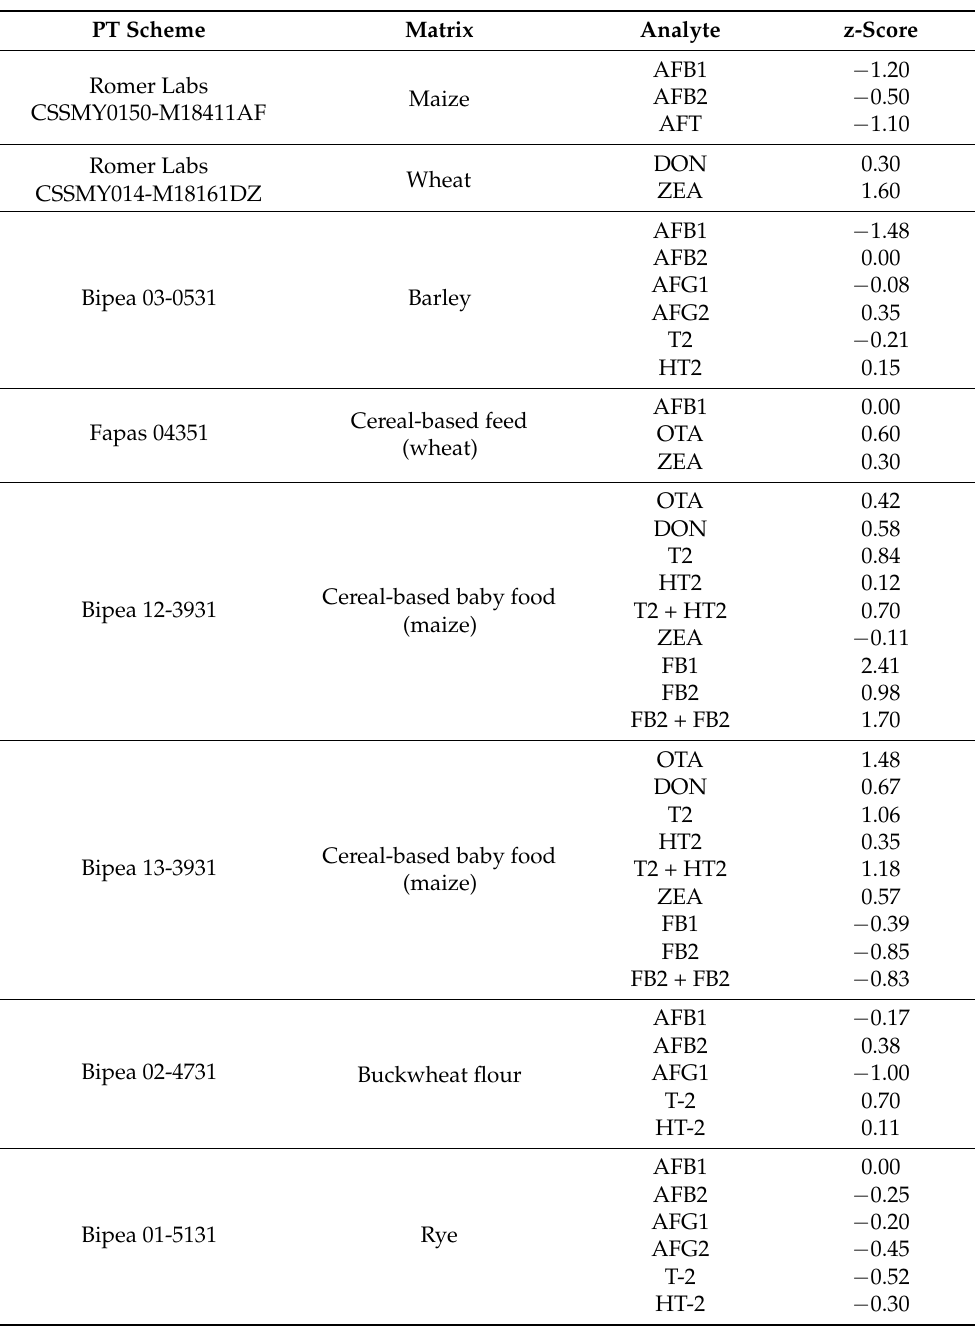
Table 10. PT results for mycotoxins in food and feed